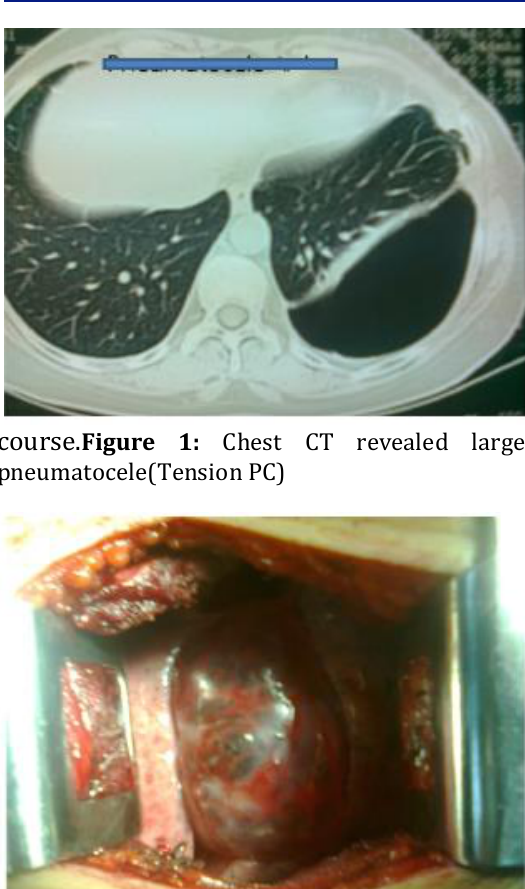
Figure 2: Intra operative mini thoracotomy showing multicysticpneumatocele.